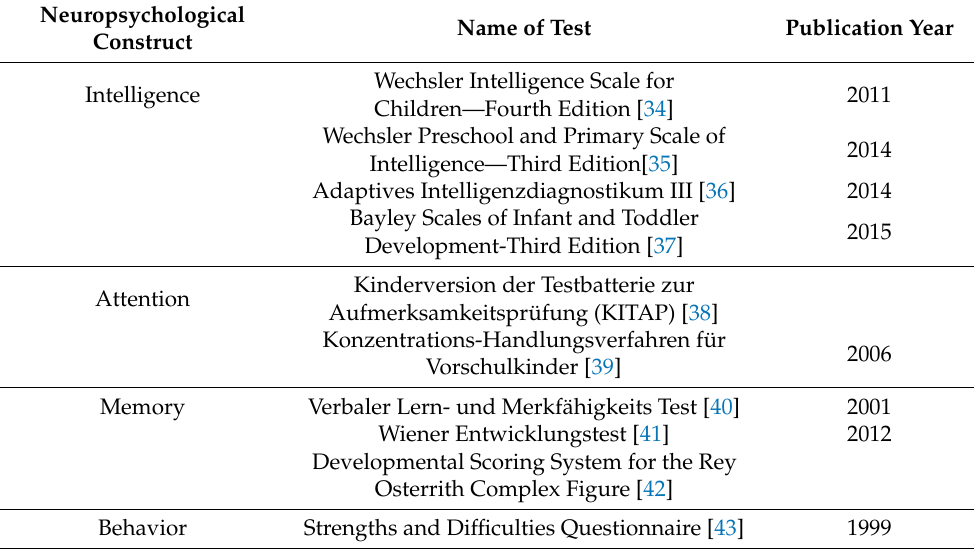
Table 2. Neuropsychological